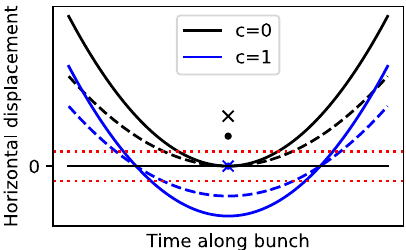
FIG. 1. Schematic showing the effect of a sextupole magnet on the slice alignment at a location downstream of the sextupole. Dashed lines correspond to a weaker sextupole strength. The crosses (strong sextupole field) and dots (weak) depict the center of mass. For positive values of the orbit adjustment factor c , two colors can be generated. The threshold of orbit misalignment necessary to suppress FEL radiation is indicated in